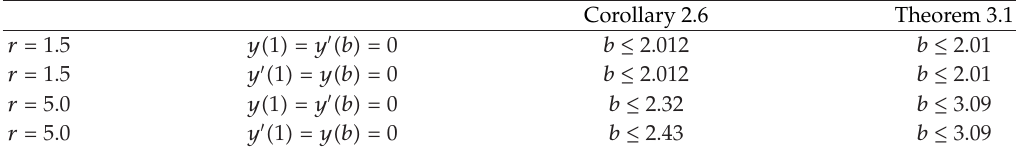
Table 3: Comparison of upper bounds for b in Example 4.3.